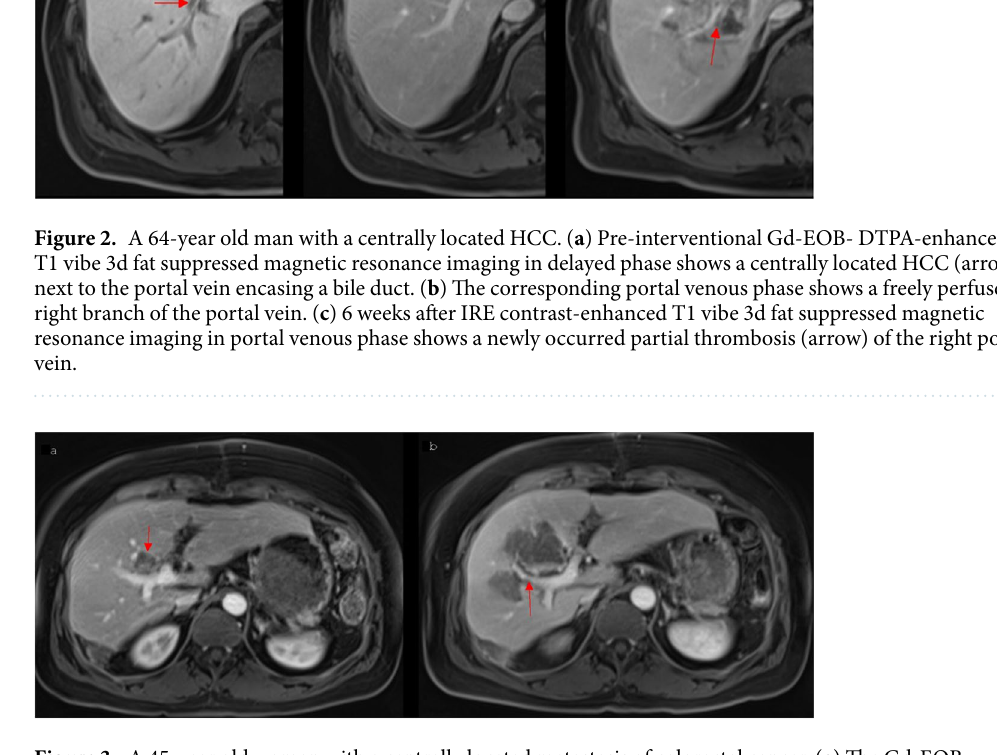
Figure 3. A 45-year old woman with a centrally located metastasis of colorectal cancer. ( a ) The Gd-EOB- DTPA-enhanced T1 vibe 3d fat suppressed magnetic resonance imaging in portal venous phase shows a centrally located metastasis (arrow) and a freely perfused right anterior branch of the portal vein. ( b ) 6 weeks after IRE imaging shows a newly occurred vessel narrowing of the portal vein branch